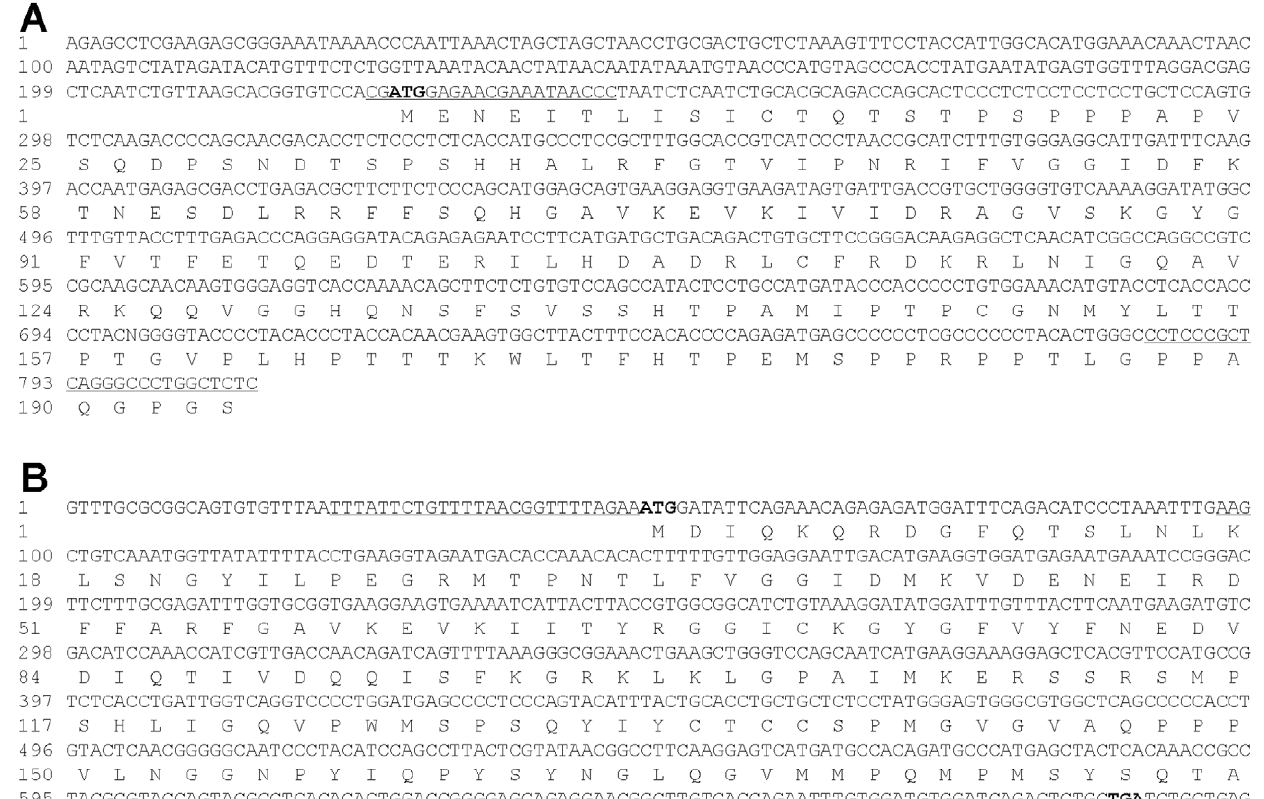
Figure 1. Nucleotide and amino acid sequences of the rainbow trout boule and dazl . (A) boule . (B) dazl . Start and stop codons are in bold. Sequences underlined are primer sequenced used for cDNA cloning and RT-PCR analysis, which also flank the regions used for the synthesis of RNA probes for in situ hybridization.